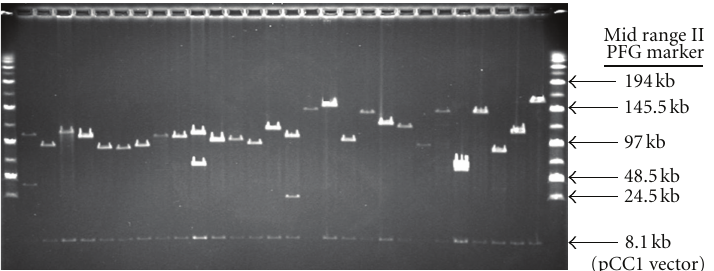
Figure 2: Estimated BAC genomic insert sizes using contour-clamped homogeneous electric field (CHEF) electrophoresis. DNA preparations were digested with Not I prior to separation on a 0.9% agarose gel in 0.5X TAE bu ff er for 24h at 4 ◦ C.